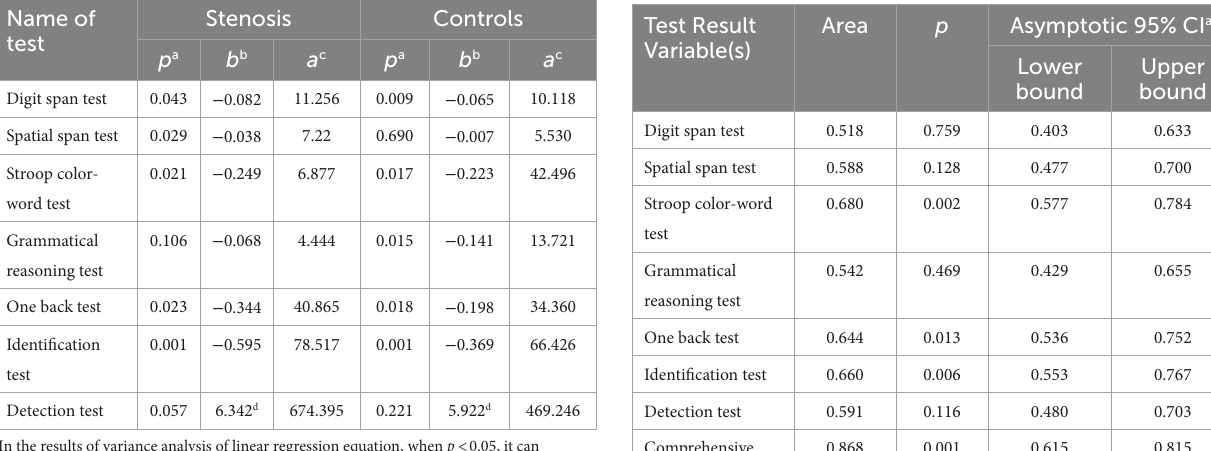
TABLE 3 The linear regression analysis between cognitive scores and age in stenosis group and control group separately.